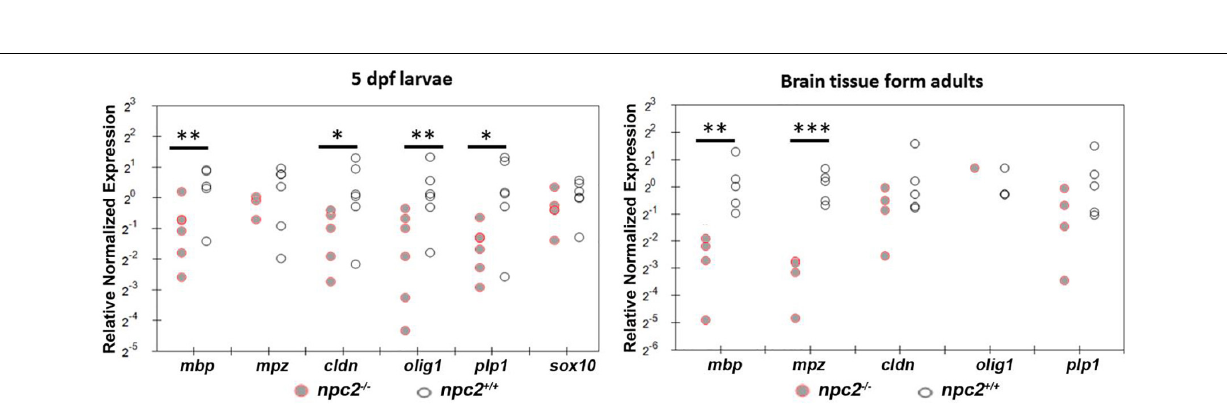
Frontiers in Cellular Neuroscience |